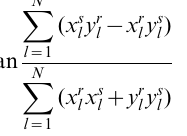
Table 2. Average process time for compared